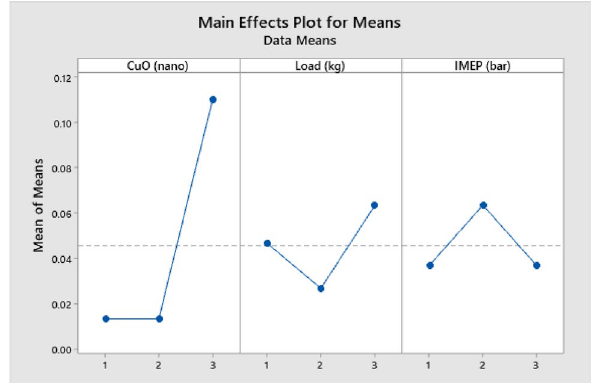
Fig. 7 Investigation by Taguchi: CO versus CuO (nano), load (kg), IMEP (bar)